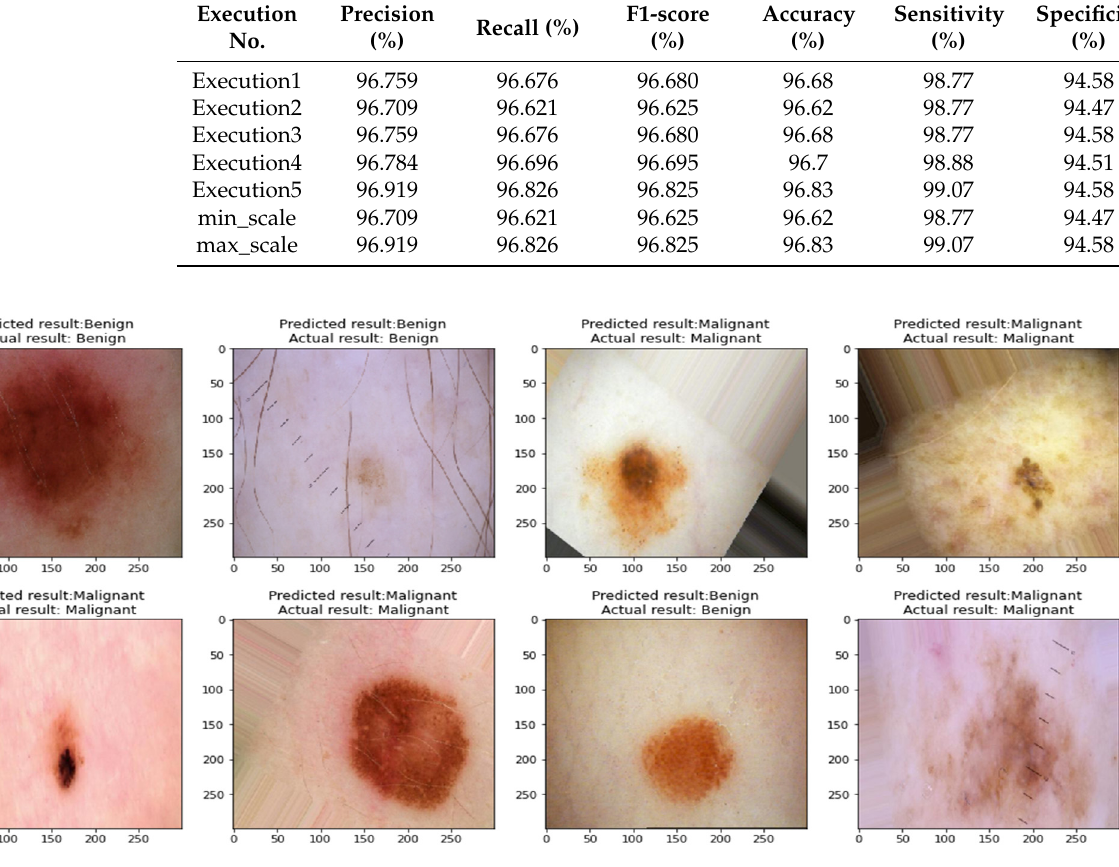
Figure 17. Images classified correctly by the proposed classifier.